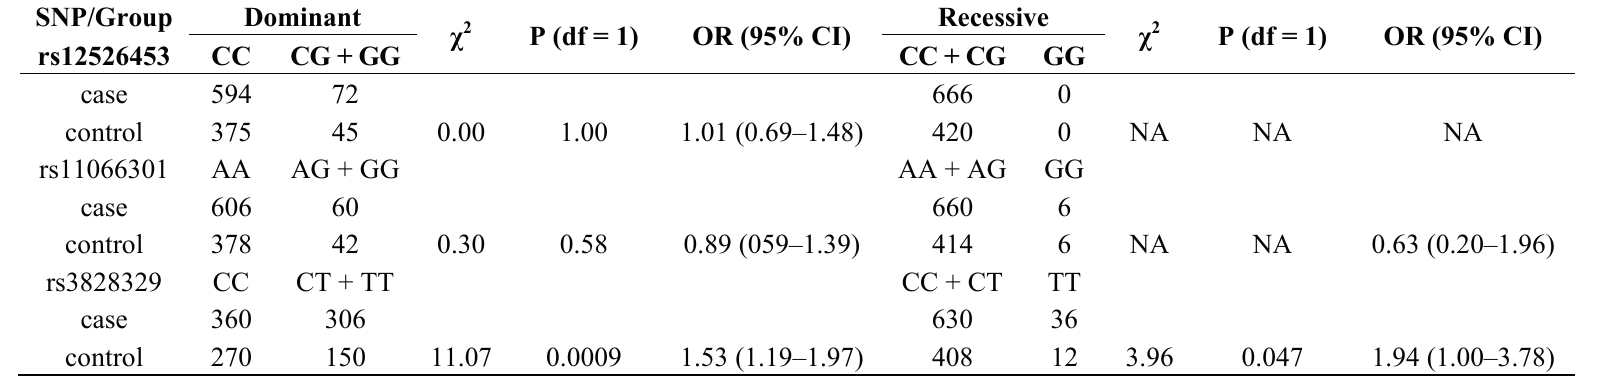
Table 2. Comparison of the dominant model and recessive model between cases and